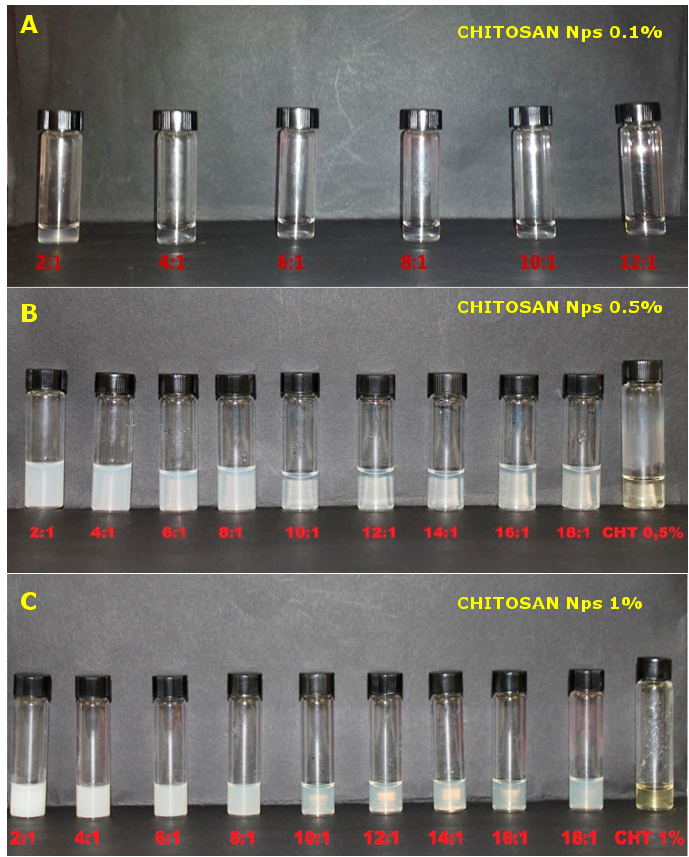
Figure 2. Image of the prepared chitosan nanoparticle dispersions in 200 mM acetate buffer pH 4.5 at the three different concentrations (0.1% ( A ), 0.5% ( B ) and 1% ( C ); w / w ).